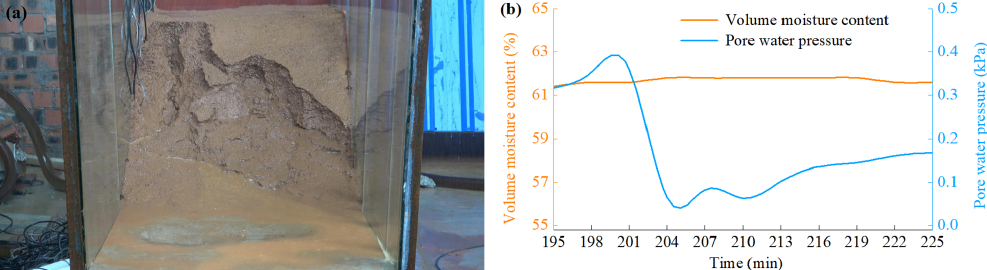
Figure 20. Typical phenomenon and result with an initial dry density of 1.40gcm − 3 . (a) Slope failure. (b) Results for sensor no. 7 closest to sliding surface.